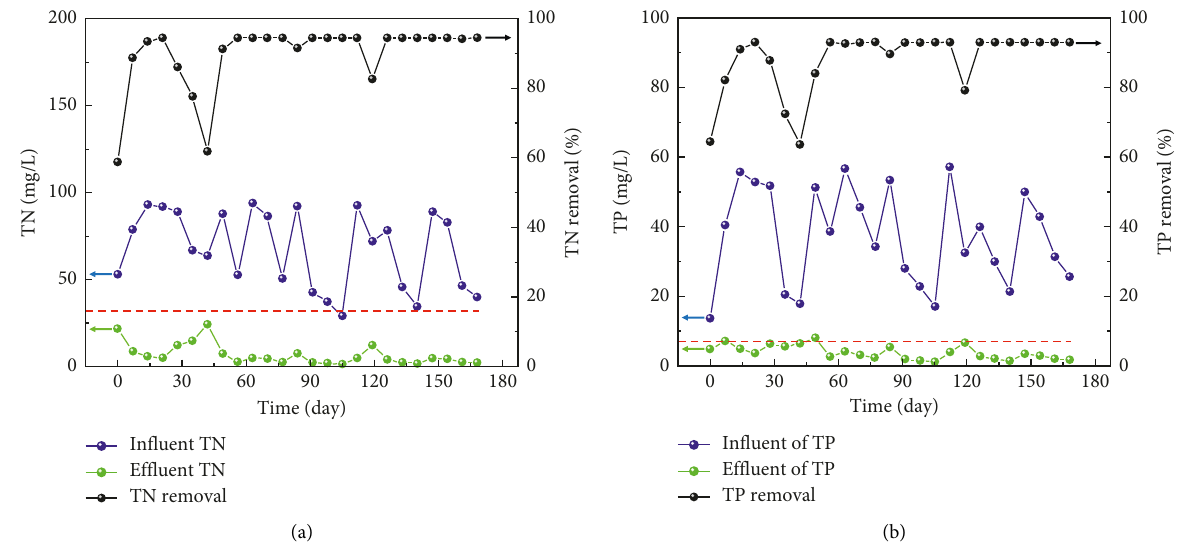
Figure 4: Nitrogen (a) and phosphorus (b) removal during the experimental